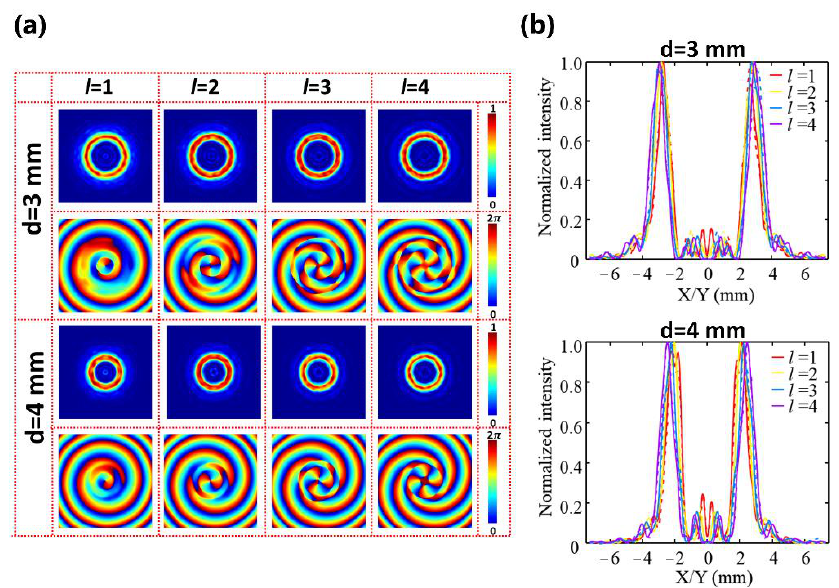
Figure 7. ( a ) The intensity and phase profiles of the PVBs with the topological charges varied from l = 1 to l = 4 when the axicon periods d were selected as d = 3 mm and 4 mm, respectively. ( b ) Corresponding normalized cross-section of the annular intensity distribution along x-direction (solid line) and y-direction (dashed line) at 0.75 THz when d = 3 mm (upper) and d = 4 mm (down), respectively.